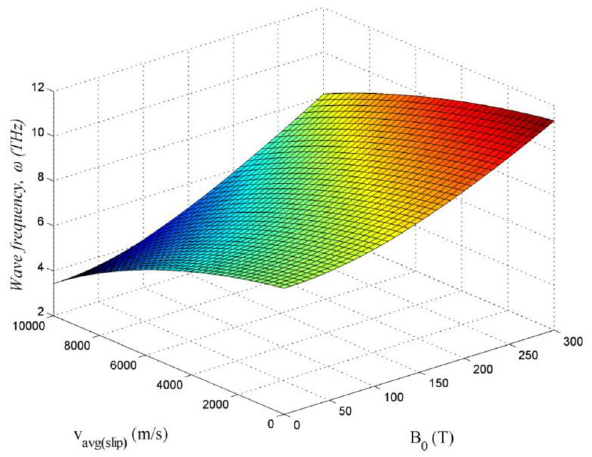
Fig. 10 The wave frequency variations with the nanoflow velocity and magnetic intensity for k = 10 ( 1 ∕ nm ) , Kn = 0.001 , l m = 0.19nm and ea =